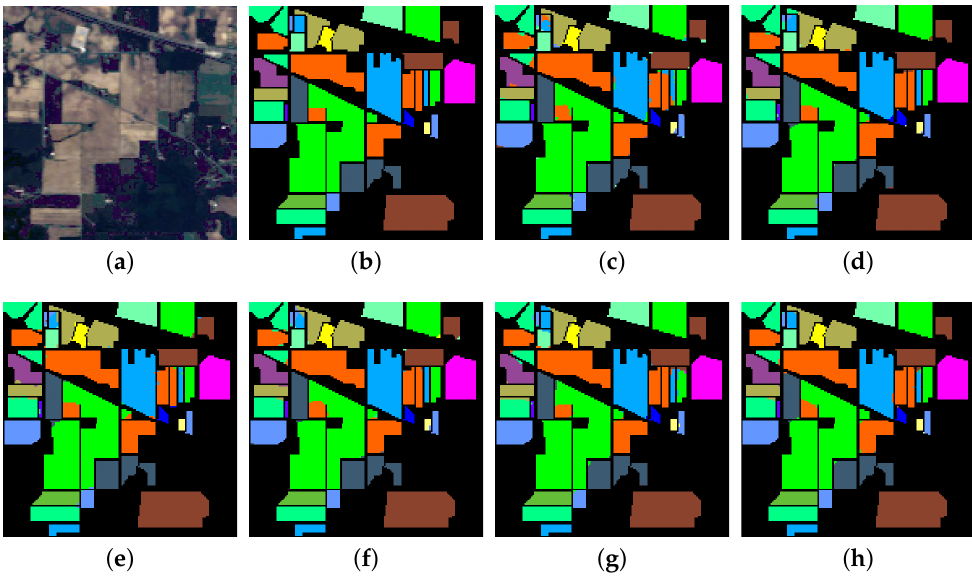
Figure 8. Indian Pines data set. ( a ) False-color composite image. ( b ) Ground reference map. The classification maps obtained by the ( c ) 3-D convolutional neural network (CNN) (97.53), ( d ) fully convolutional layer fusion network (FCLFN) (98.47), ( e ) deep feature fusion network (DFFN) (98.43), ( f ) DenseNet (98.64), ( g ) ResNet (99.01) and ( h ) MPRN (99.16). Note that the overall classification accuracies (in %) are shown in brackets. Table 5. Classification accuracies (%) obtained by different methods on the Houston University data set. The improvement of MPRN over ResNet is also provided. The best results are highlighted in bold font. In addition, the positive and negative improvements are marked in blue and red, respectively.